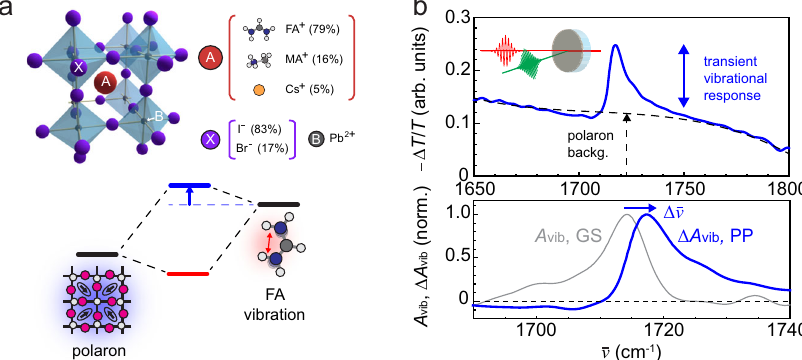
Fig. 4 Polaron – cation coupling in hybrid organic – inorganic perovskite FAMACs. a Chemical composition and structure of FAMACs perovskite (top), polaron – cation coupling and associated blue-shift of molecular vibration (bottom). b Far- fi eld transmission visible-pump (2.4 eV) IR-probe spectrum at T = 0.5 ps (top), the ground-state (GS) vibrational absorbance A vib and transient absorbance Δ A vib (bottom). NATURE COMMUNICATIONS| (2022) 13:1083